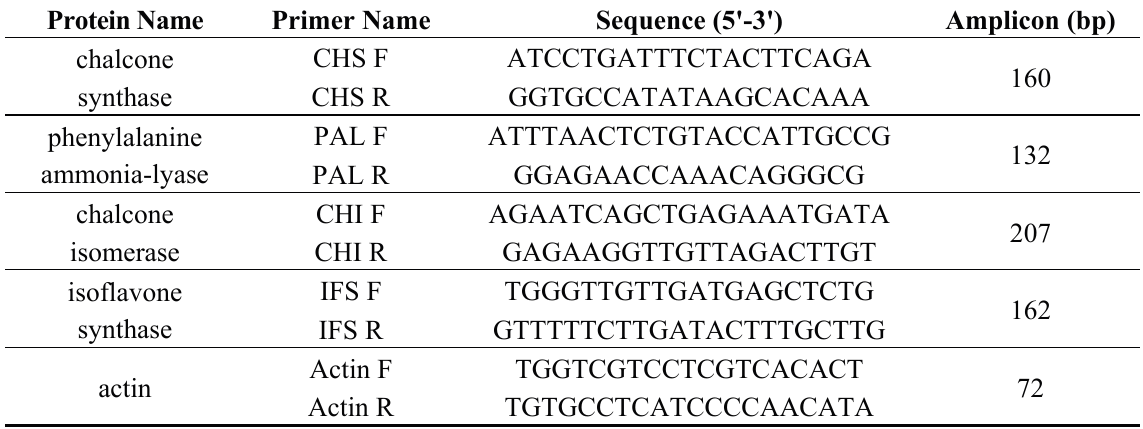
Table 1. Real-time PCR primers used for quantification of mRNA levels of different